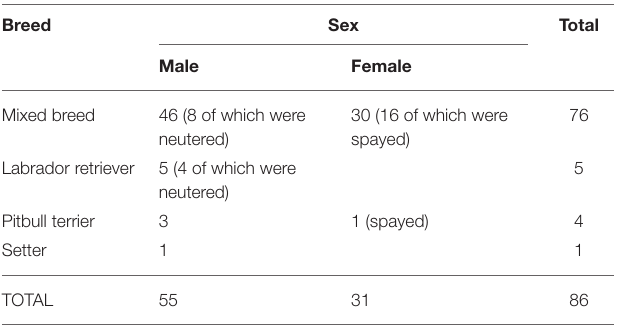
deviation (mean ± SD). The mean ± SD of the CBC value was TABLE 2 | Distribution of breed and sex in study population.